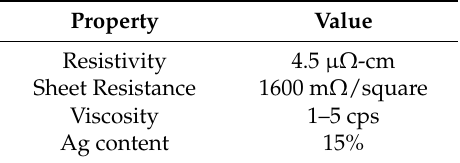
Figure 1. Schematization of the Inkjet Printing (IJP) actuator. Table 1. Main specifications of “Metalon ® JS-B15P”. Courtesy by Novacentrix.